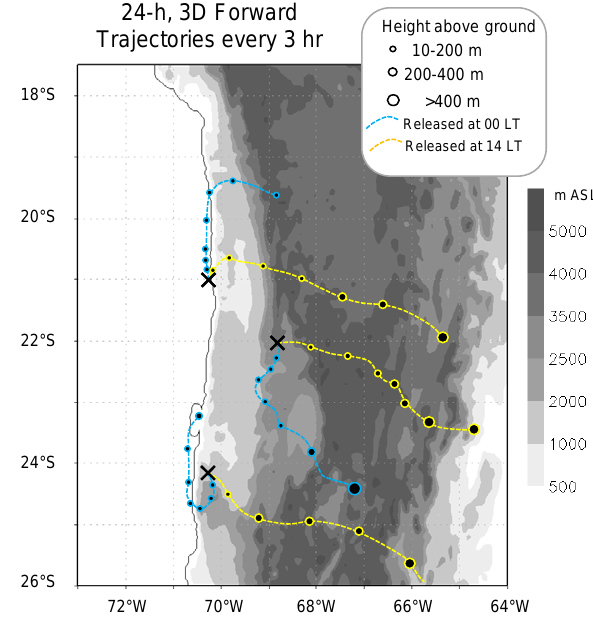
Fig. 11. Forward trajectories calculated using a simple advec- tive scheme and the WRF-simulated diurnal mean (4-day aver- age) three-dimensional wind field ( U,V,W ). Three release loca- tions were chosen (black crosses) and the parcels were followed for the next 24h. The figure shows the parcel’s location every 3h (cir- cles) superimposed on a topographic map. The circle size indicates parcel height above terrain (see scale atop). Yellow (blue) symbols indicate the trajectories of parcels released at 14:00LT